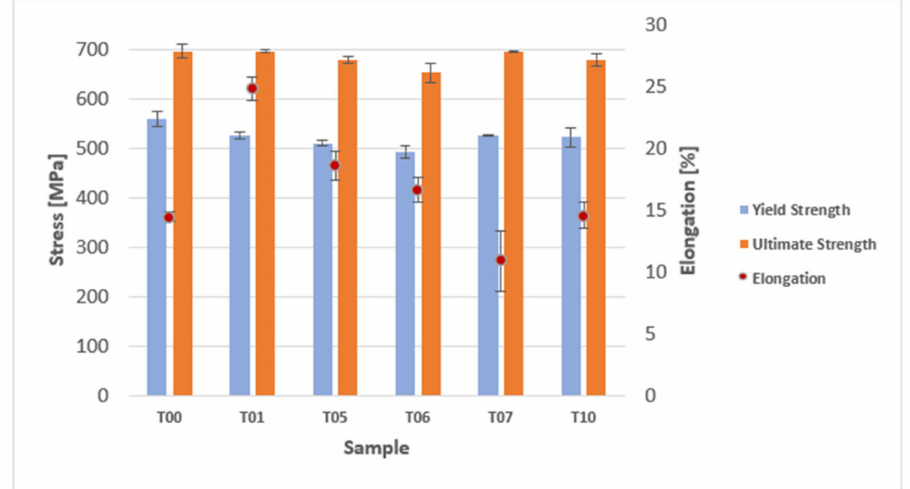
Figure 5. Results of the tensile tests performed at room